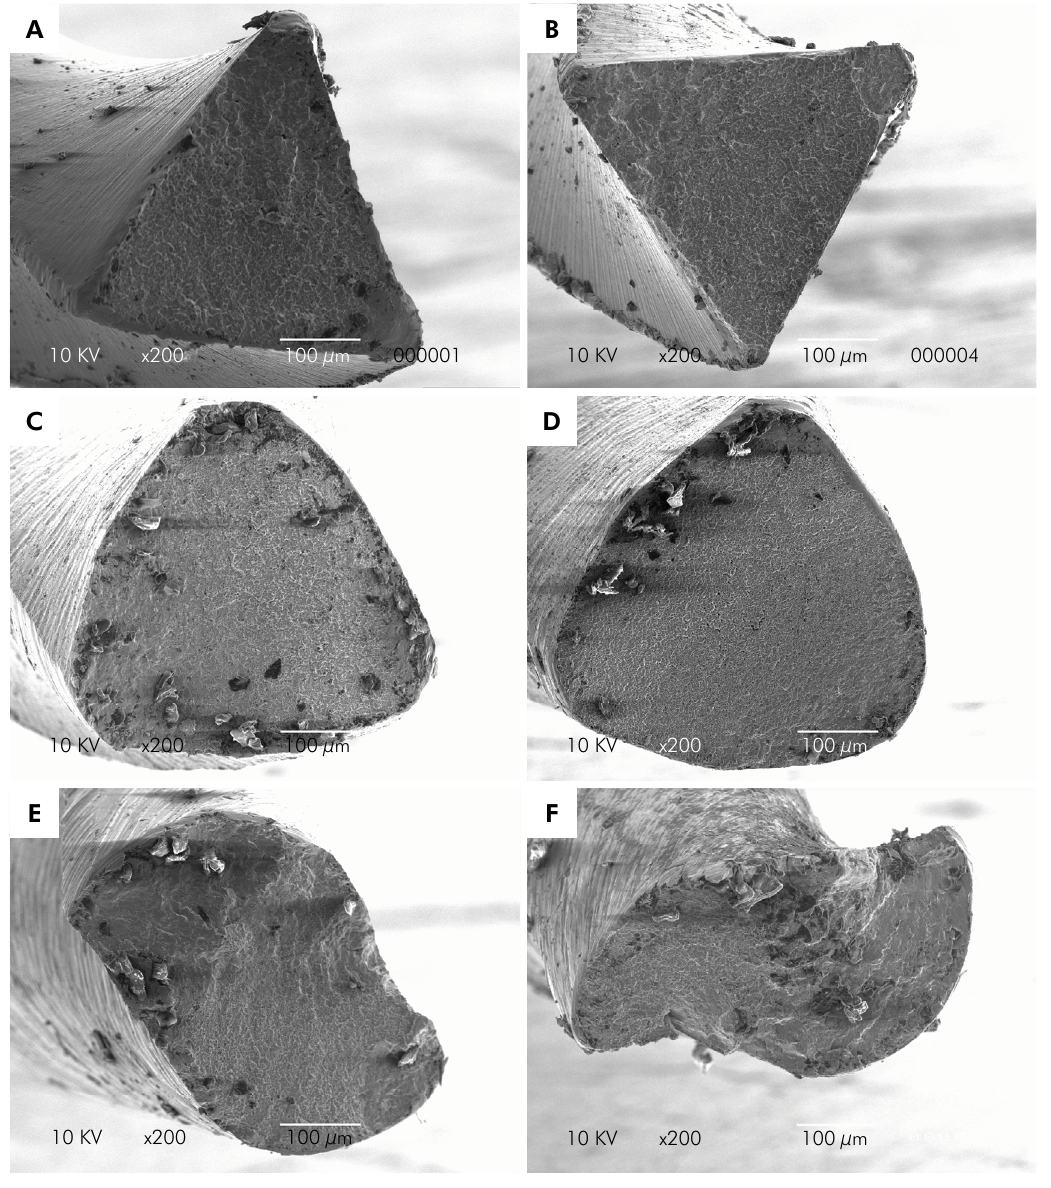
Figure 4. Scanning electron microscopy images of new (A, C, and E) and used (B, D, and F) instruments of BT-Race, Sequence Rotary File, and ProDesign Logic systems, respectively, after cyclic fatigue